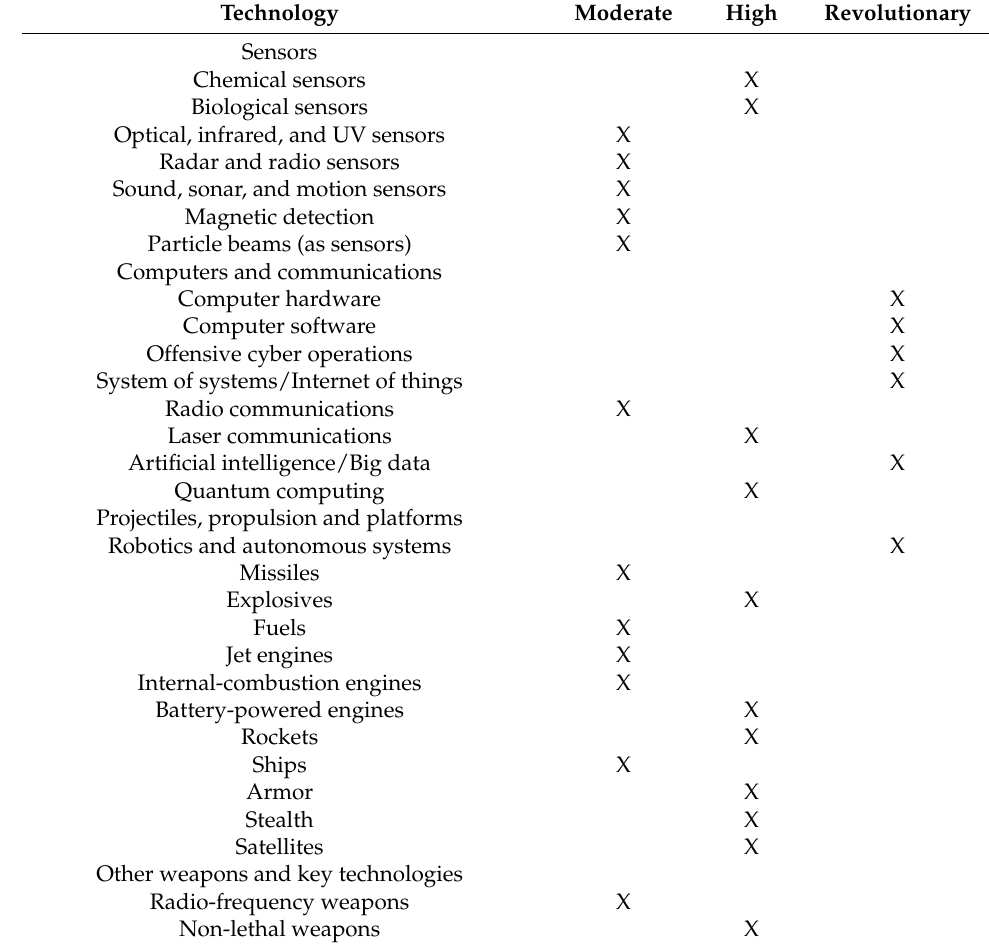
Table 3. Military Sensor